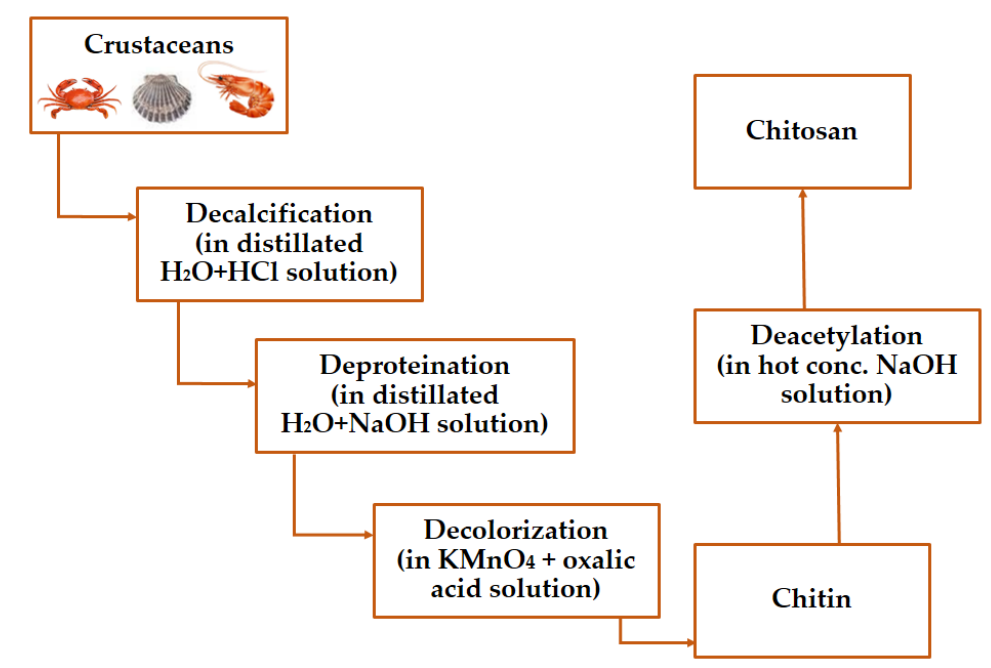
Figure 1. Chitosan extraction methods from crustaceans.